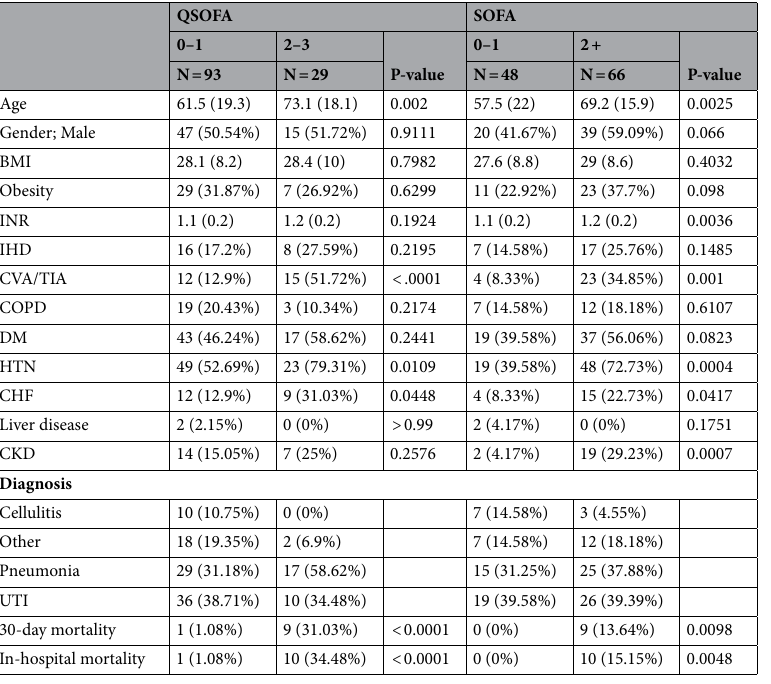
Table 1. Demography and medical history. Categorical variables were analyzed with a chi-square test (or with Fisher’s exact test). Continuous variables are presented as the mean (SD). For continuous variables, the t-test